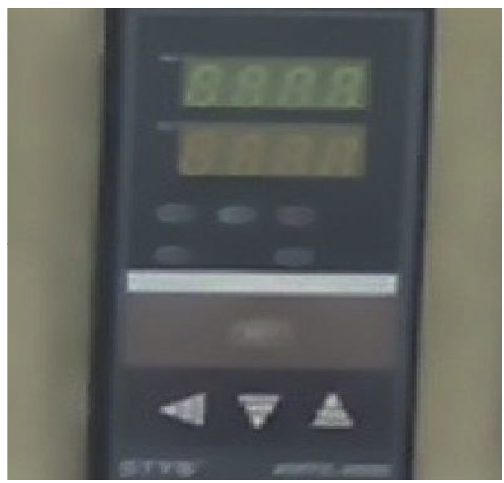
Figure 6: Setting heating temperature.